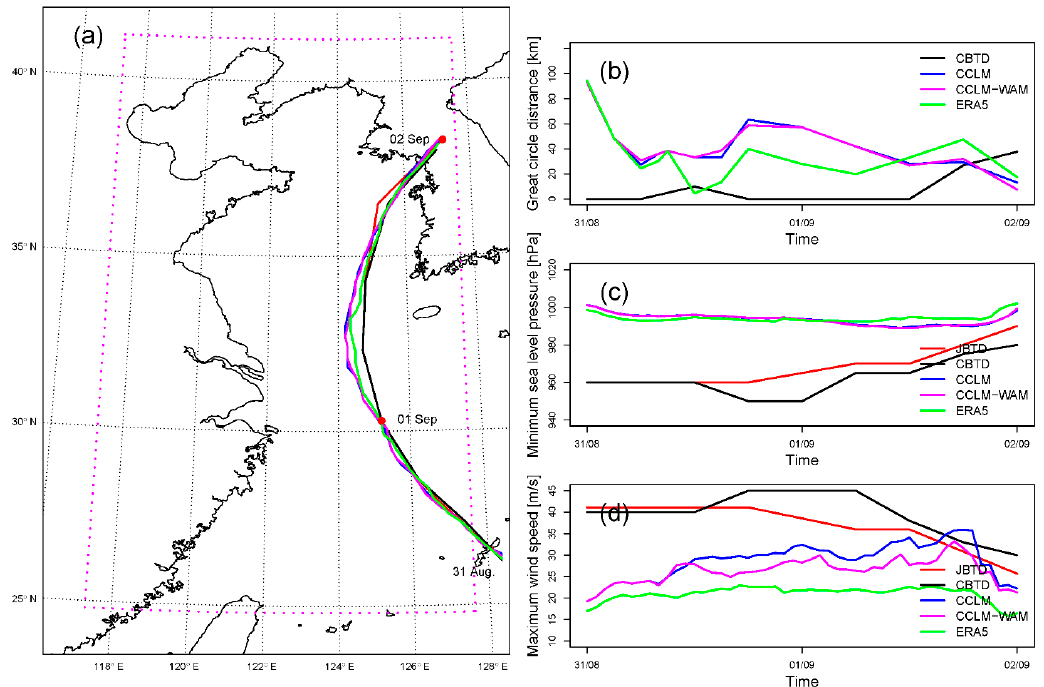
Figure 9. ( a ) Tracks of typhoon Kompasu from Best Track Data of Japan Meteorological Agency (red line, JBTD) and China Meteorological Agency (black line, CBTD), and corresponding model results, time series of ( b ) great circle distance between model simulations (CBTD) and JBTD, ( c ) the minimum sea-level pressure and ( d ) maximum 10-m wind speed. Magenta points in (a) indicate the domain of standalone WAM simulation/coupling simulation.